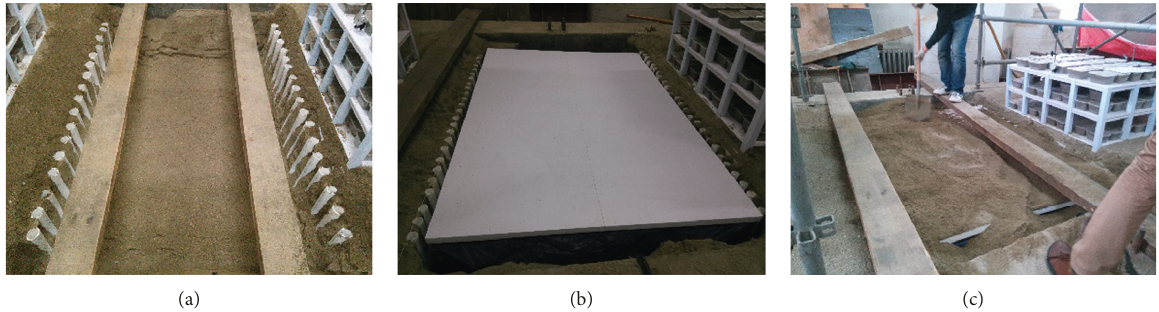
Figure 10: Existing building models with load blocks: (a) support structure and excavation; (b) the underground structure; (c) backfill of cover soil.